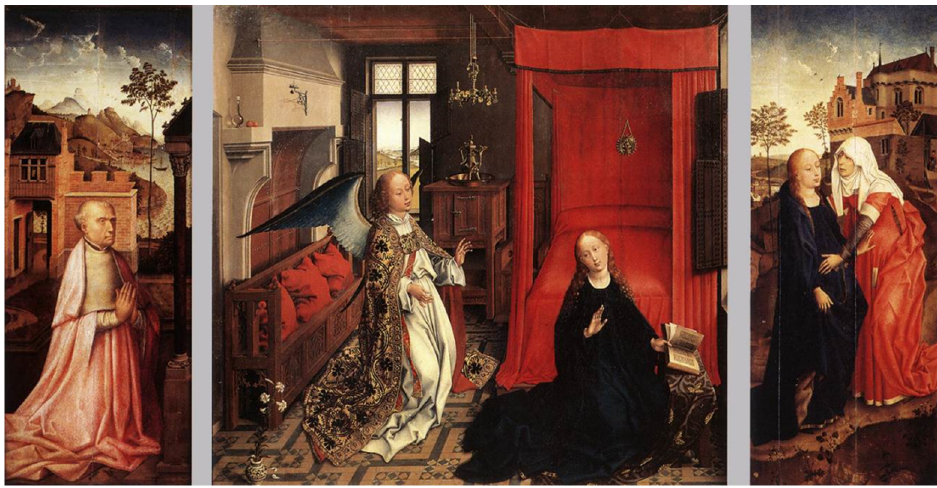
Figure 12. Rogier van der Weyden and workshop, Annunciation Triptych , ca. 1435–1440. Oil on oak; 89 × 36 cm (wings). Paris, Musée du Louvre (centre panel) and Torino, Galleria Sabauda (wings). © 89 × 36 cm (wings). Paris, Mus é e du Louvre (centre panel) and Torino, Galleria Sabauda